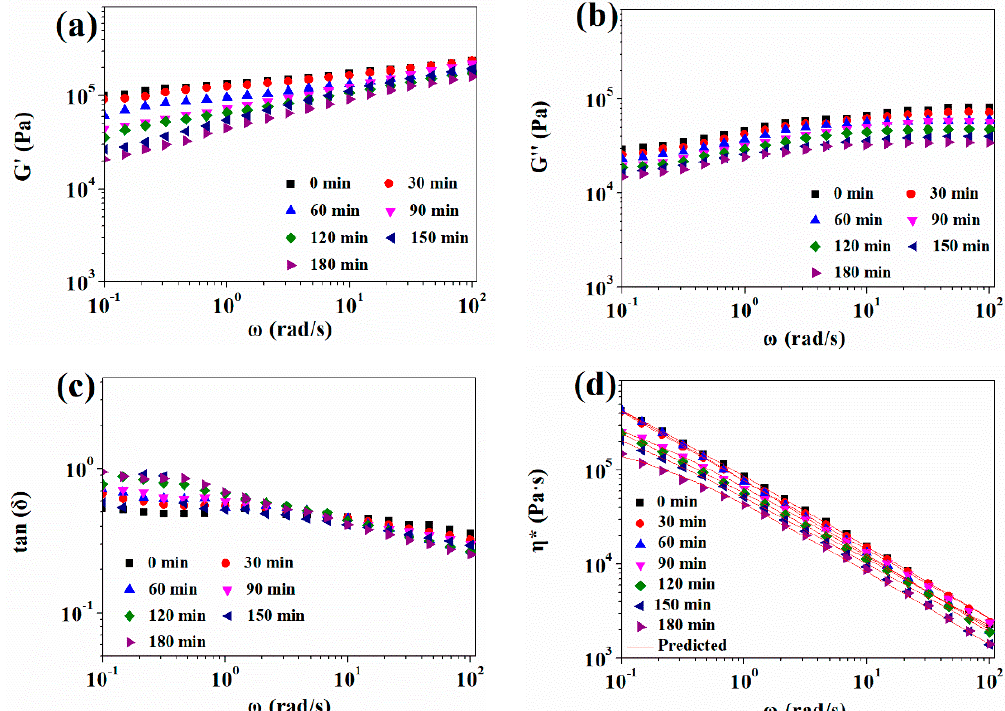
Figure 5. Rheological behavior of pre-vulcanized silicone rubber samples being treated with different CO 2 saturation times at 35 °C: ( a ) Storage modulus G’ ; ( b ) Loss modulus G’’ ; ( c ) Loss angle tan ( δ ); ( d ) Complex viscosity η * . Table 2. Rheological parameters of pre-vulcanized silicone rubber samples being treated with dif- ferent CO 2 saturation times.